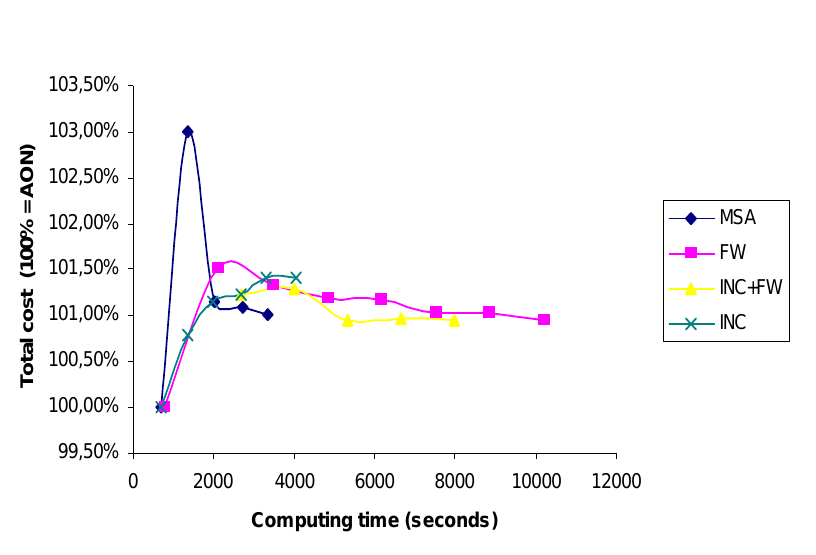
Figure 8. Assignment results on a real case